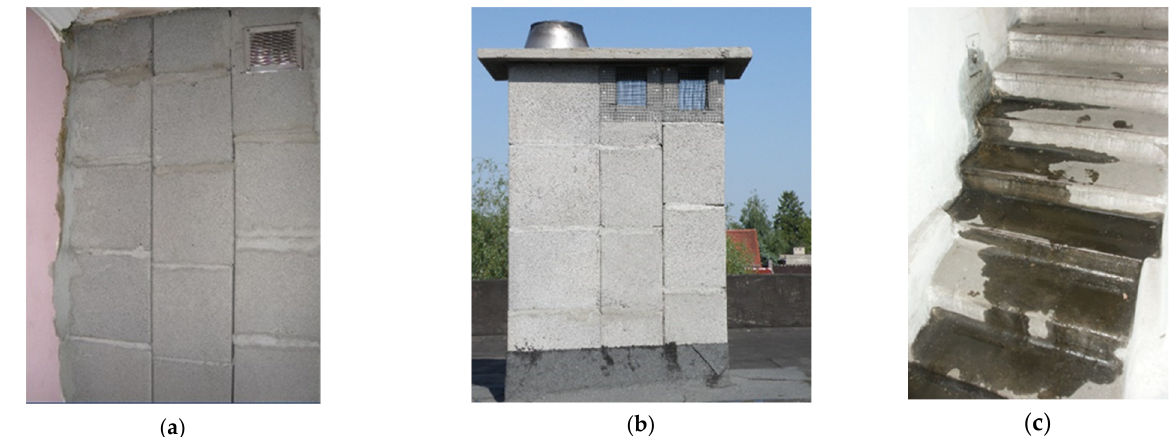
Figure 8. Prefabricated ventilation flue pipes: ( a ) inside the building, ( b ) above the roof, ( c ) condensation leakage in the